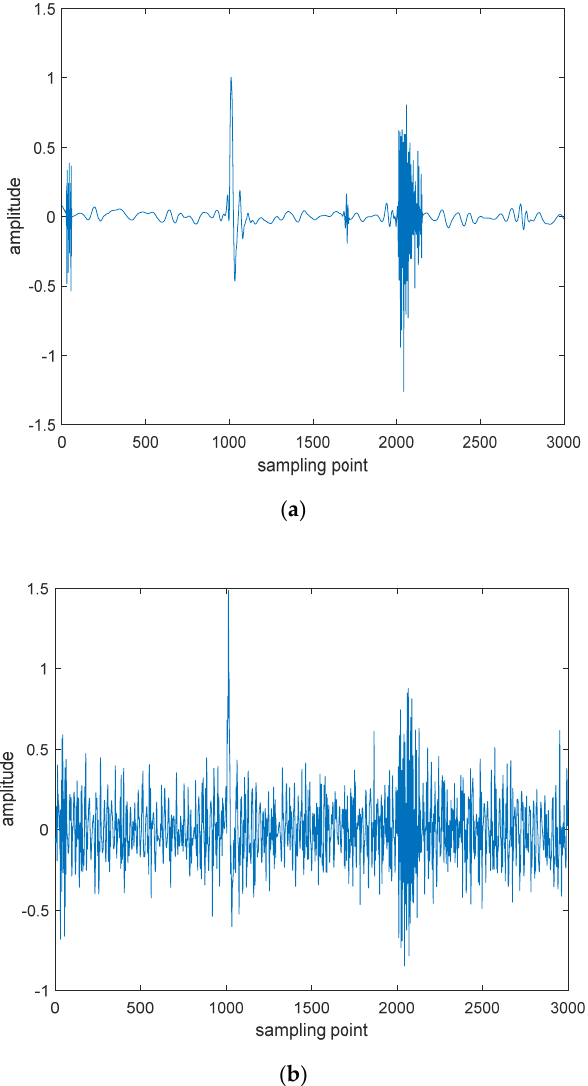
Figure 14. Final reconstructed PD. ( a ) Proposed method and wavelet thresholding. ( b ) EMD.